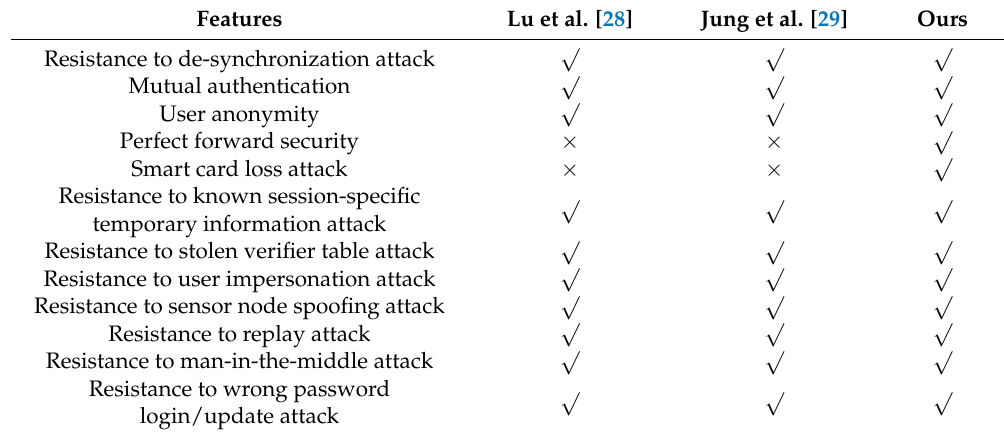
Table 2. Security features comparisons of our scheme and the two related schemes.